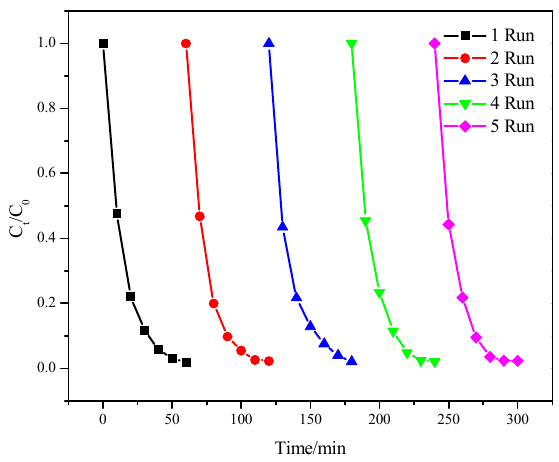
Figure 12. The stability of the PFC / PS system for the degradation of NOR with 10 mg / L initial concentration under optimal conditions.